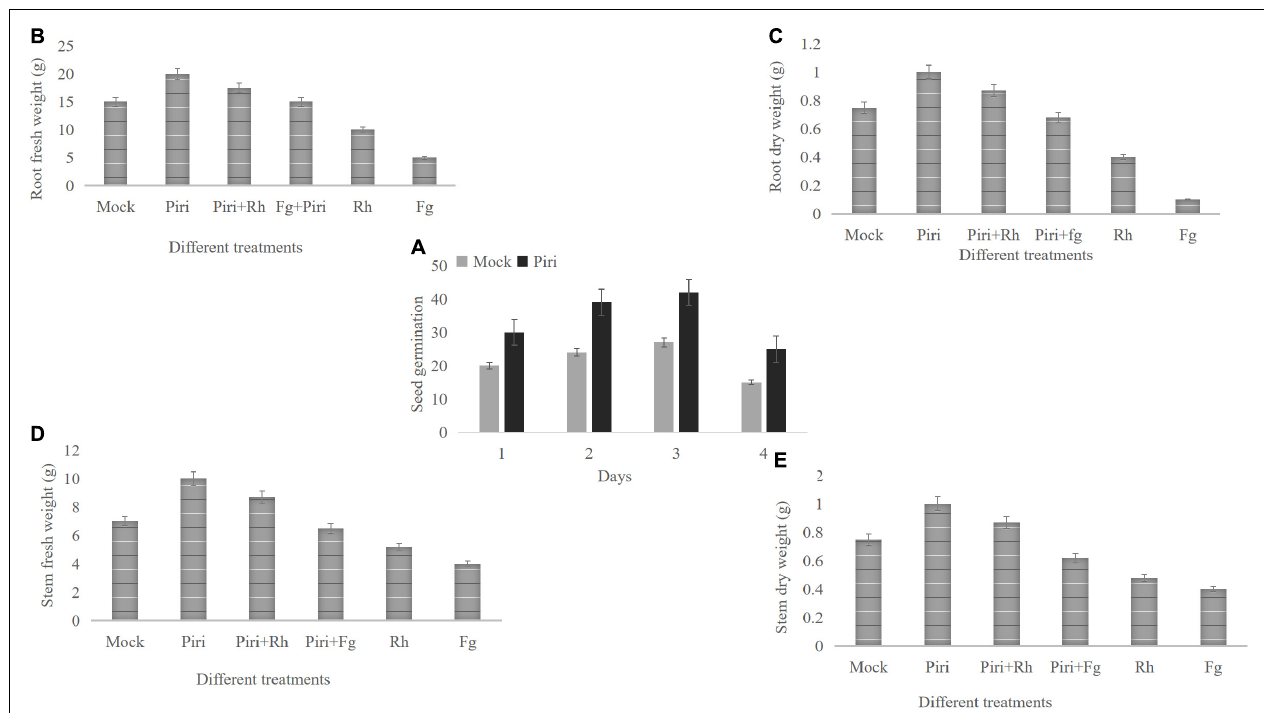
FIGURE 2 | Effect of various treatments of Piri, Fg, Piri + Fg, Rh, and Piri + Rh on wheat seedlings growth parameters. (A) Seed germination number; (B) root fresh weight; (C) root dry weight; (D) stem fresh weight; (E) stem dry weight. Samples were treated as shown in Table 1 and harvested at 14 dpi with F. graminearum or R. cerealis. Piri, P. indica ; Fg, F. graminearum ; Rh, R. cerealis ; Piri + Fg, P. indica + F. graminearum ; Piri + Rh, P. indica + R.